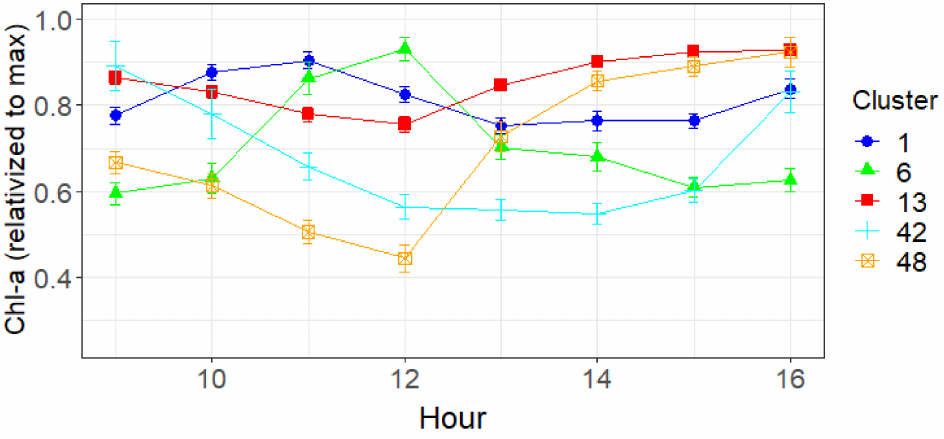
Figure 5. Average hourly (UTC time) Chl-a (with standard error), relativized to maximum value per